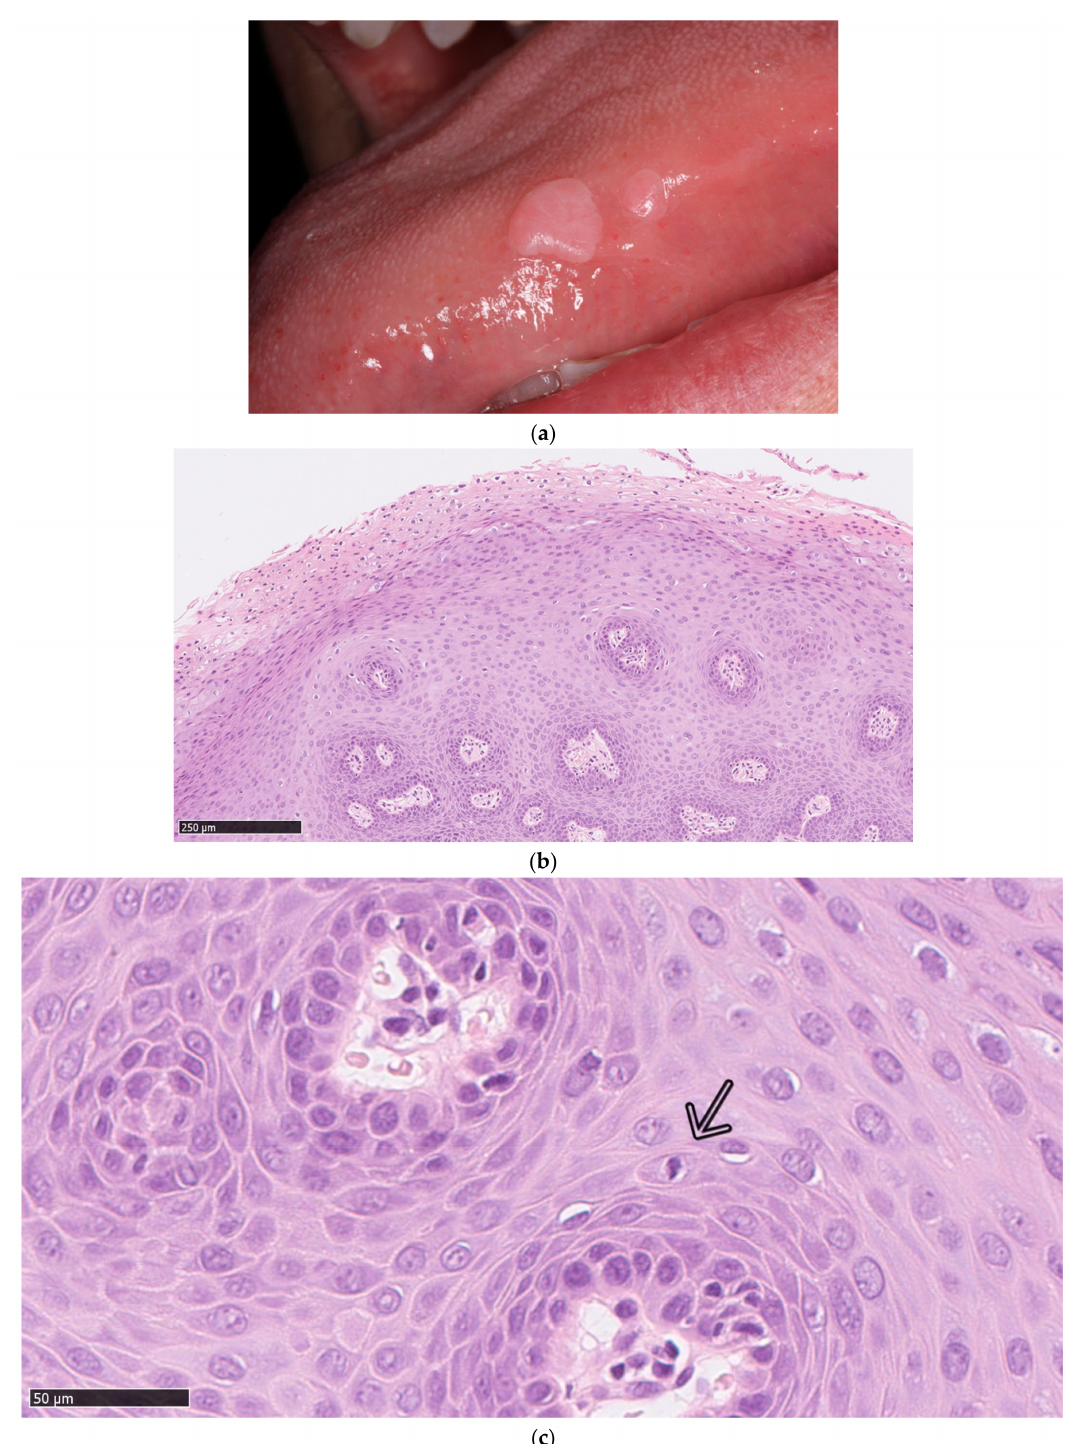
Figure 1. Clinical manifestations of focal epithelial hyperplasia (FEH). ( a ) Clinical photo of two minor FEH lesions located on the lateral side of the tongue. ( b ) Example of a histopathological examination of an FEH lesion (H&E stain) from a 56-year-old Danish female. The lesion was located on the inside of the lower lip and the diagnosis was based on the clinical and histopathological examination. The biopsy revealed a small, flat squamous papilloma with conspicuous koilocytosis that was characterized by several layers of cells with hyperchromatic nuclei with irregular contours and a perinuclear halo. HPV90 was detected with PCR using the VisionArray HPV Chip 1.0. There were no signs of dysplasia or malignancy. ( c ) Example of a mitosoid body (indicated by an arrow) from the FEH lesion described in ( b